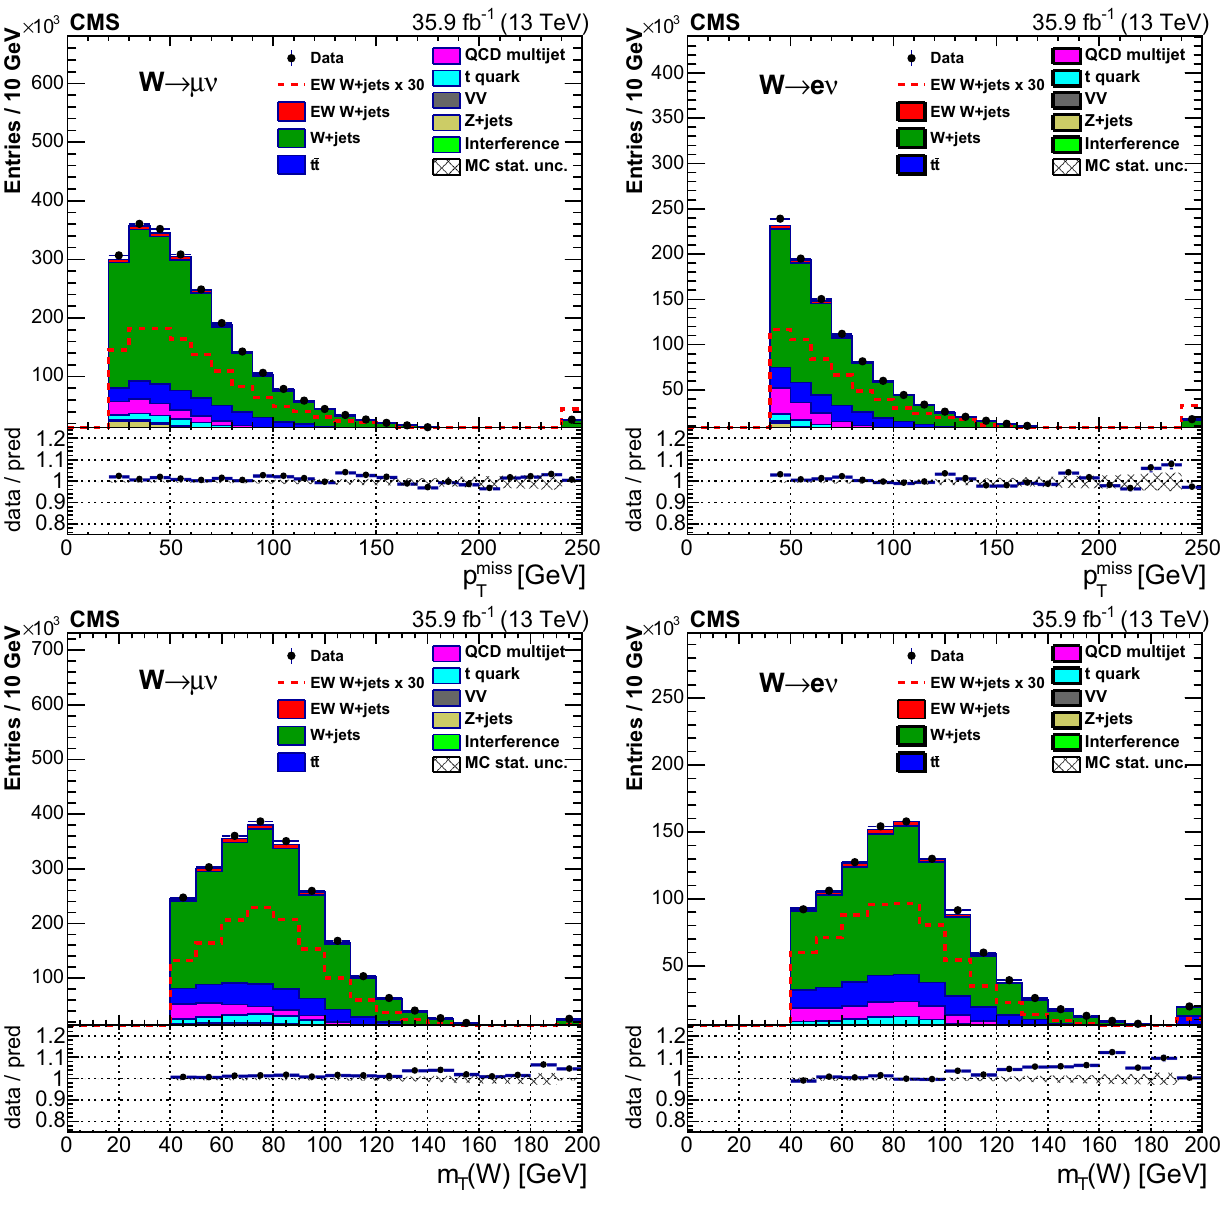
Fig. 4 Distribution of the missing transverse momentum (upper) and the lepton– p miss for the selected leading lepton in the event, in the muon (left) and electron (right) channels. In all plots the last bin contains overflow events